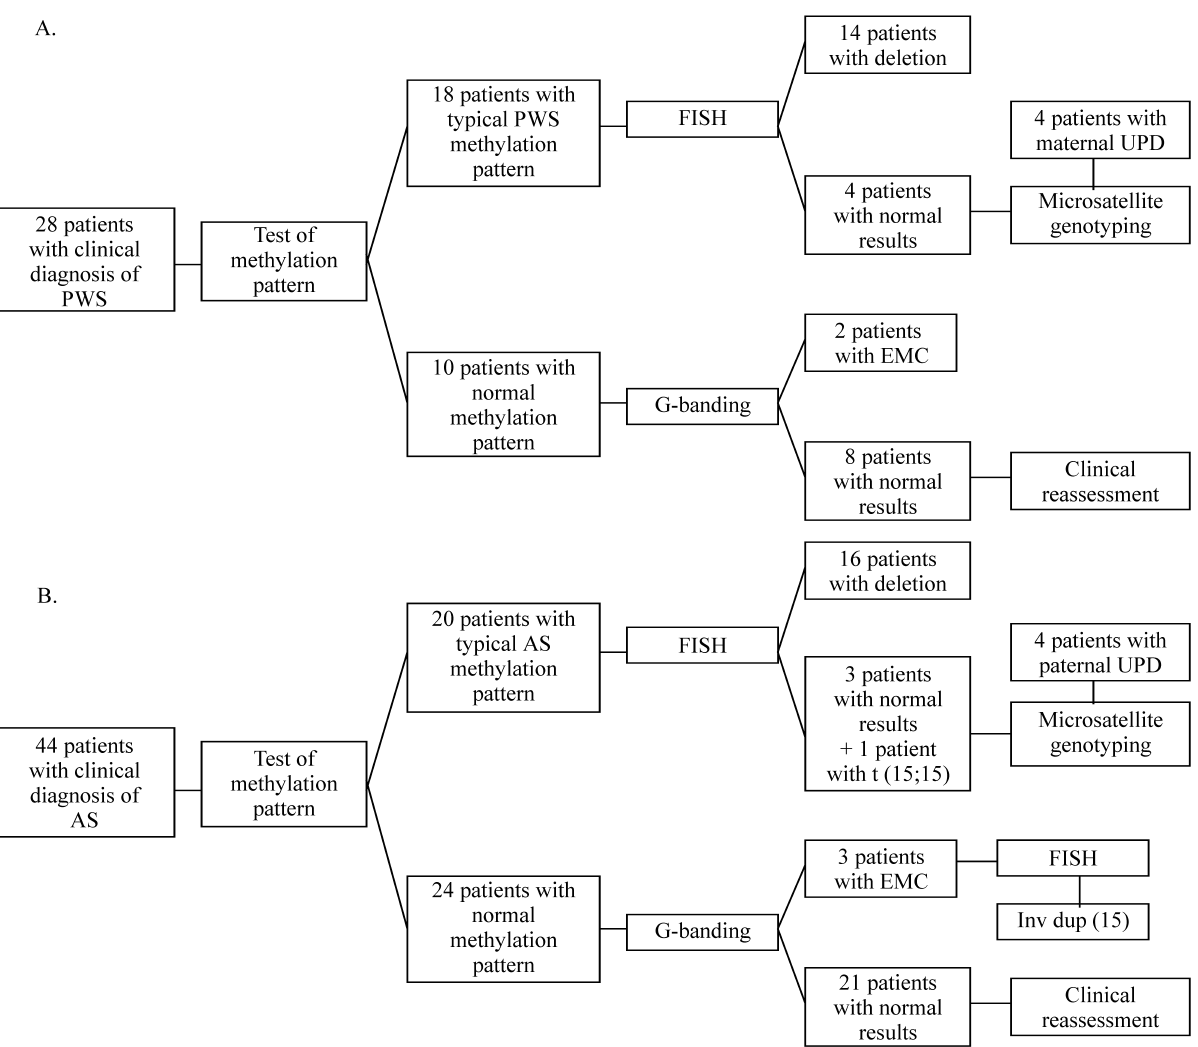
Figure 2 - A summary of the cytogenetic and molecular findings of 28 patients with clinical diagnosis of PWS (A) and 44 patients with clinical diagnosis of AS